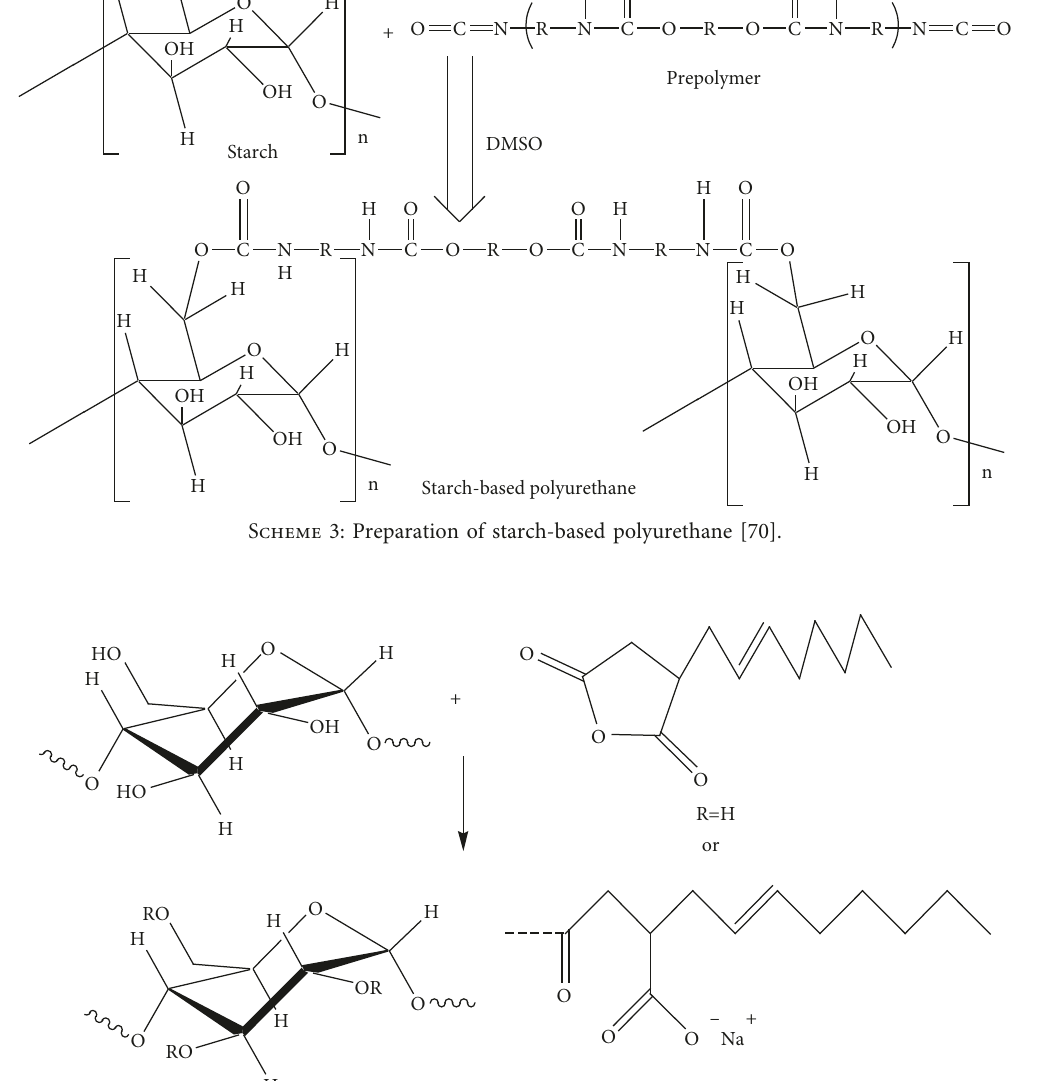
Scheme 4: Reaction showing starch modified with octenyl succinic anhydride